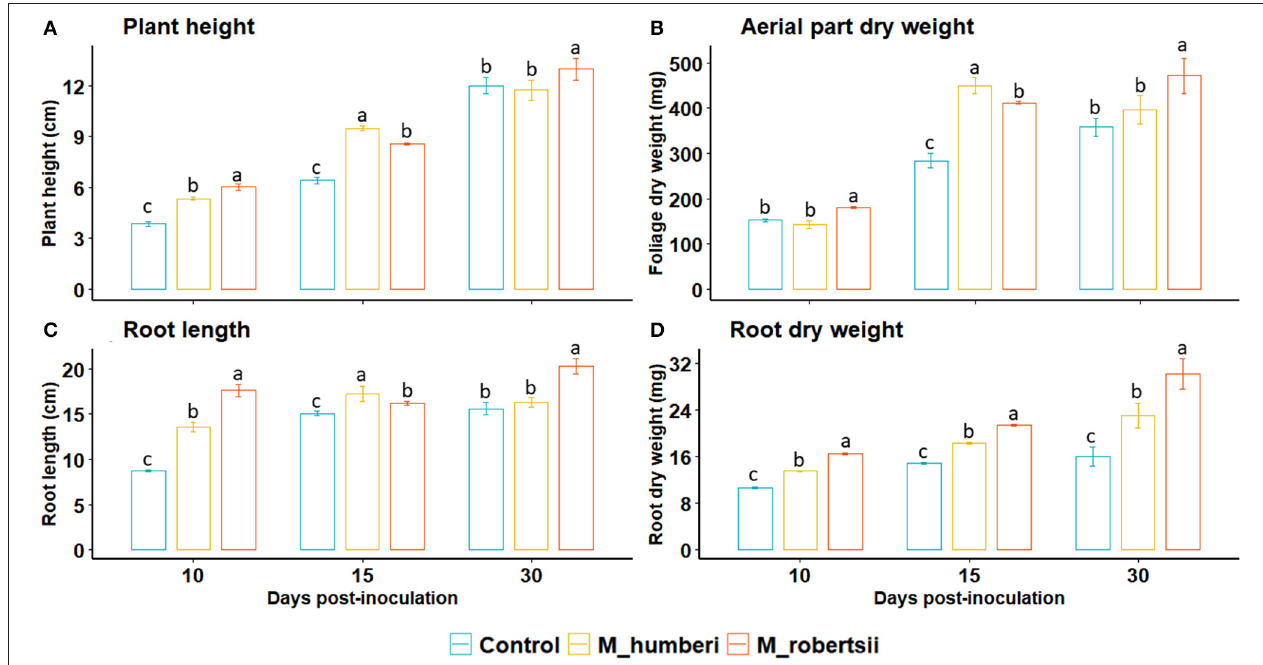
FIGURE 1 | Aerial part (A,B) and root (C,D) growth traits of Micro-Tom plants inoculated with M. robertsii or M. humberi recorded after 10, 15, and 30 days after inoculation. Vertical bars (mean ± 95% CI [confidence interval], n = 20 replicates); distinct letters indicate significant differences among the treatments within each time interval at P < 0.05 (Tukey HSD